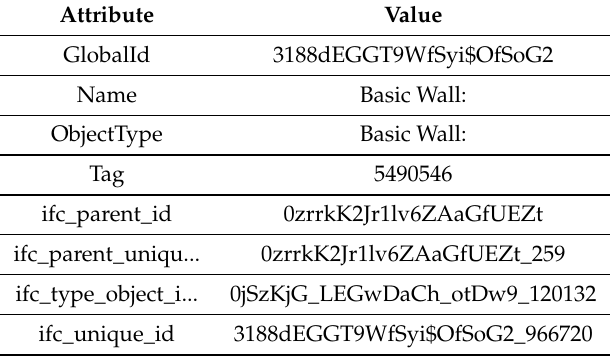
Table 12. Example of attributes associated to the GenericCityObjects in which the Uptown model was converted.